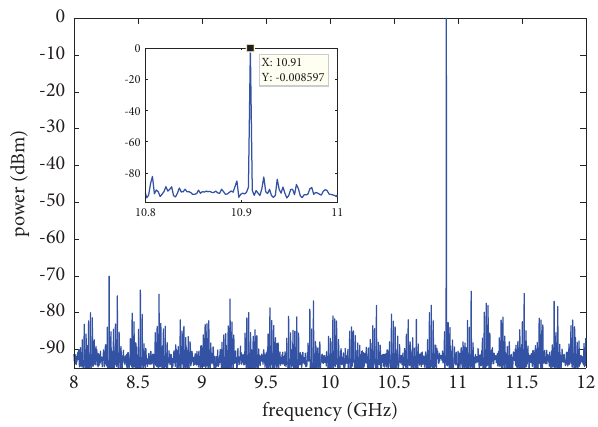
Figure 4: Frequency scanning source single-frequency spectrum.